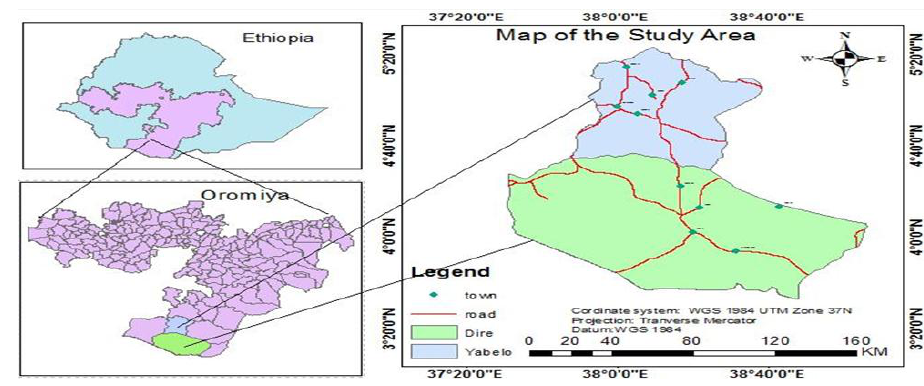
Fig. 1. Map of the study areas and the geographical